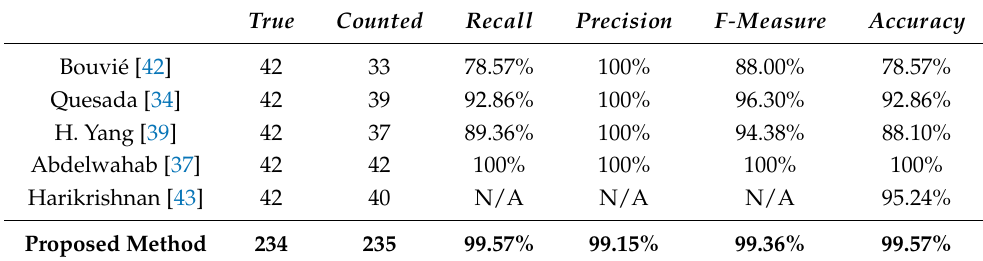
Table 18. Comparison results of the benchmark